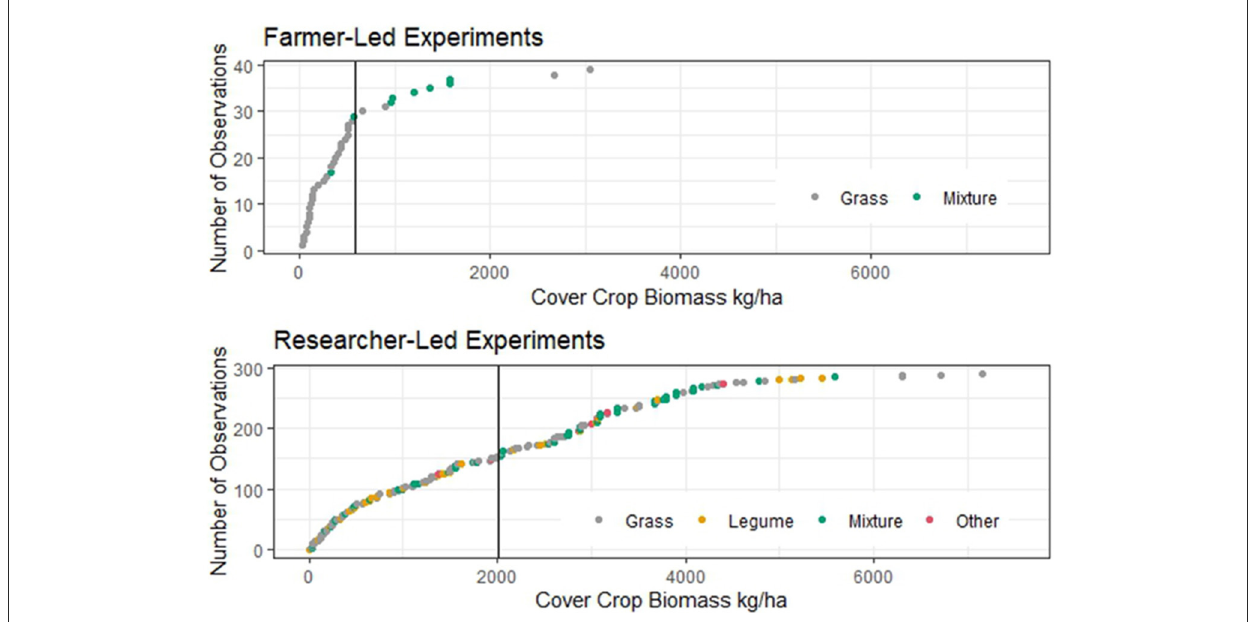
FIGURE4 Cover crop biomass in kg/ha in farmer-led and researcher-led trials for all comparisons in the database. The cover crops for which biomass information was analyzed were grasses (gray dots), legumes (orange dots), mixtures (green dots) and other (red dots). The vertical black line indicates the average of all